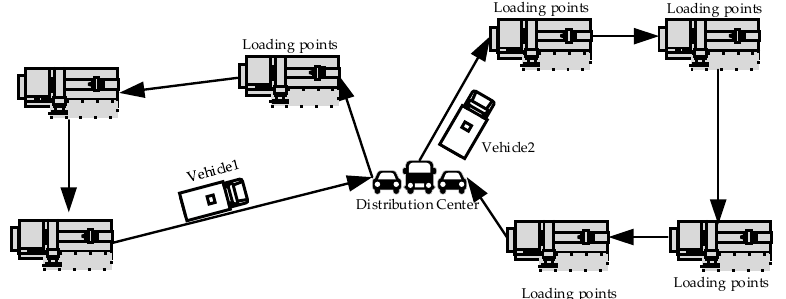
Figure 2. Illustration for the proposed problem.